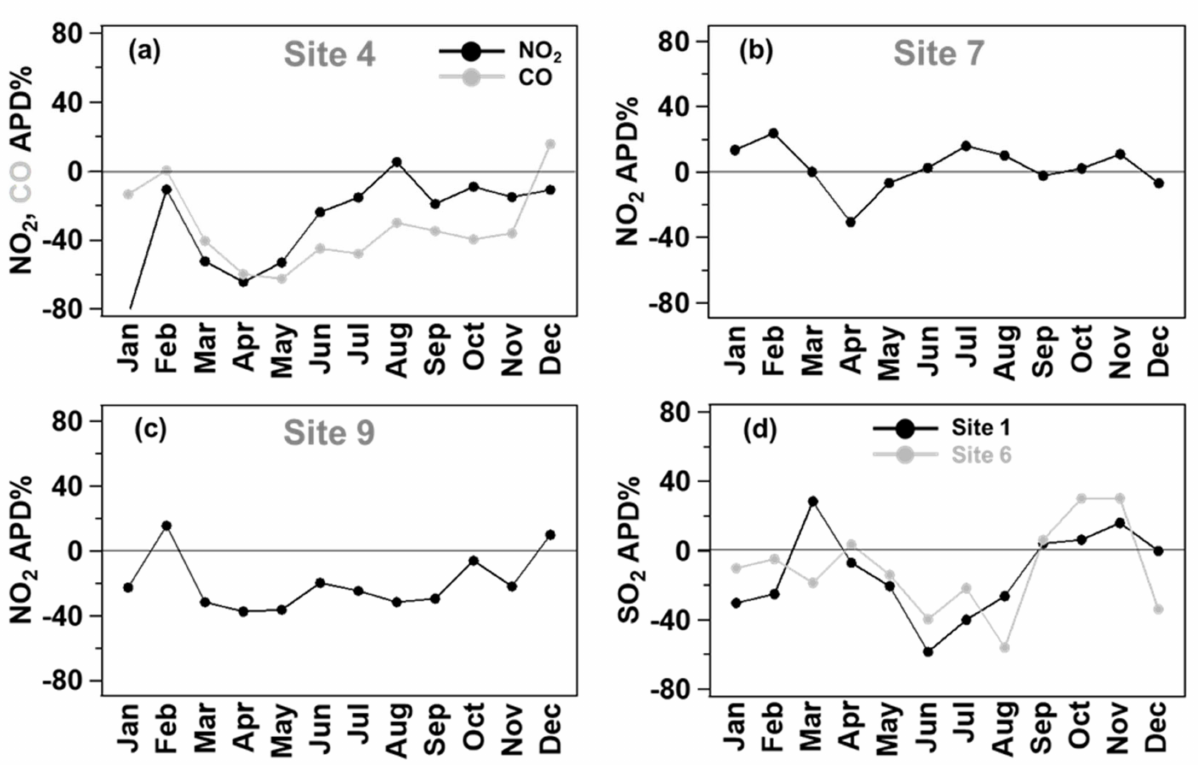
Figure 10. Monthly evolution of Average Percent Departure (APD%) of ( a ) NO 2 (black) and CO (grey) mass concentration for Site 4 (Lecce—Libertini), NO 2 mass concentration for ( b ) Site 7 (Campi Salentina) and ( c ) Site 9 (Cerrate), and ( d ) SO 2 mass concentration for Site 1 (Maglie, black) and Site 6 (Surbo,